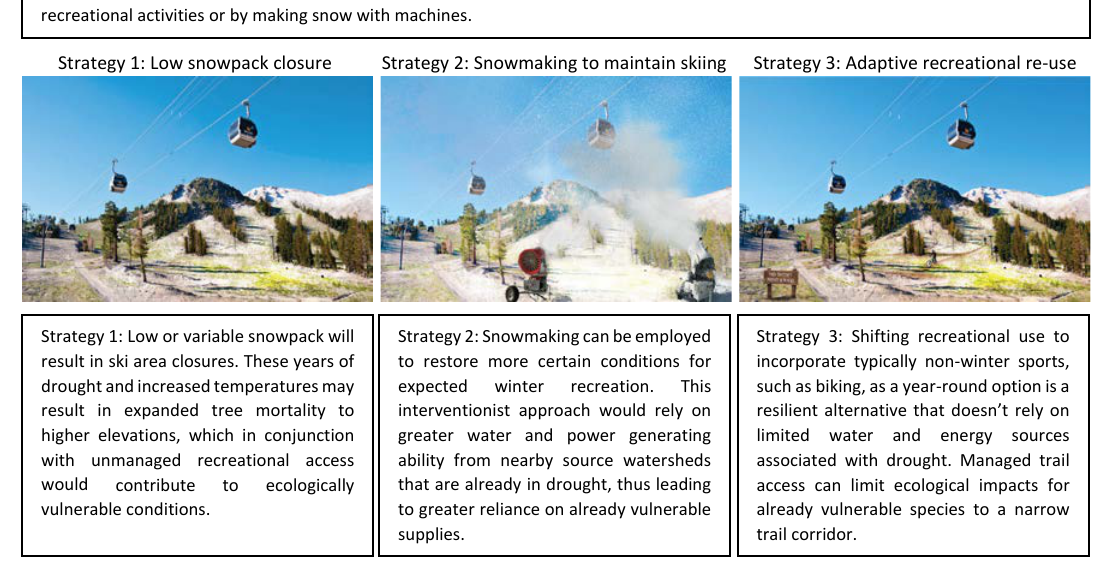
Fig. A1.12 - Site 12: Mammoth Mountain Ski